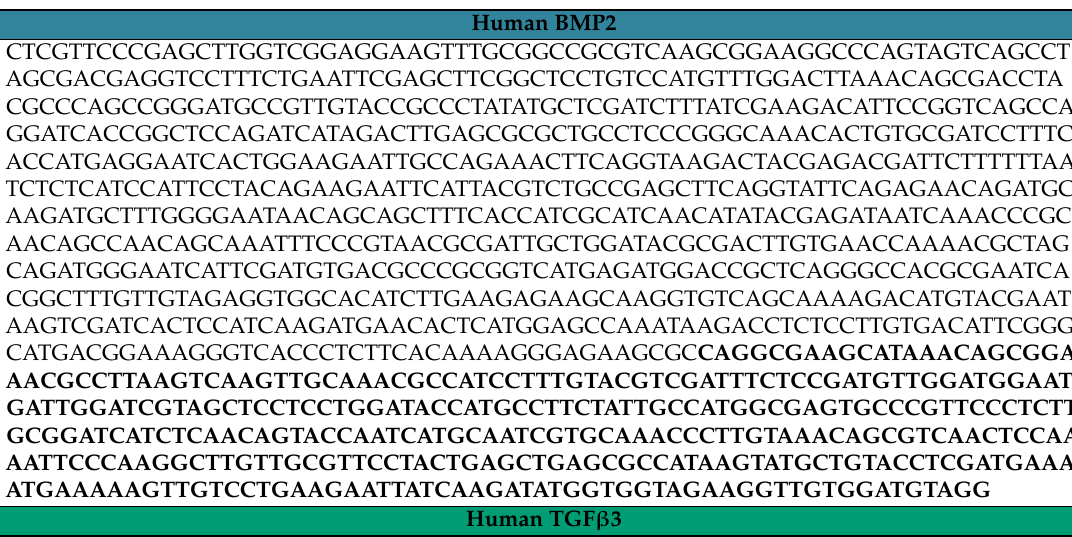
Table 1. The sequence of human BMP2 and TGF β 3 inserts. The black text indicates the propeptide sequence and the colored text indicates the sequence of the active domain of each growth